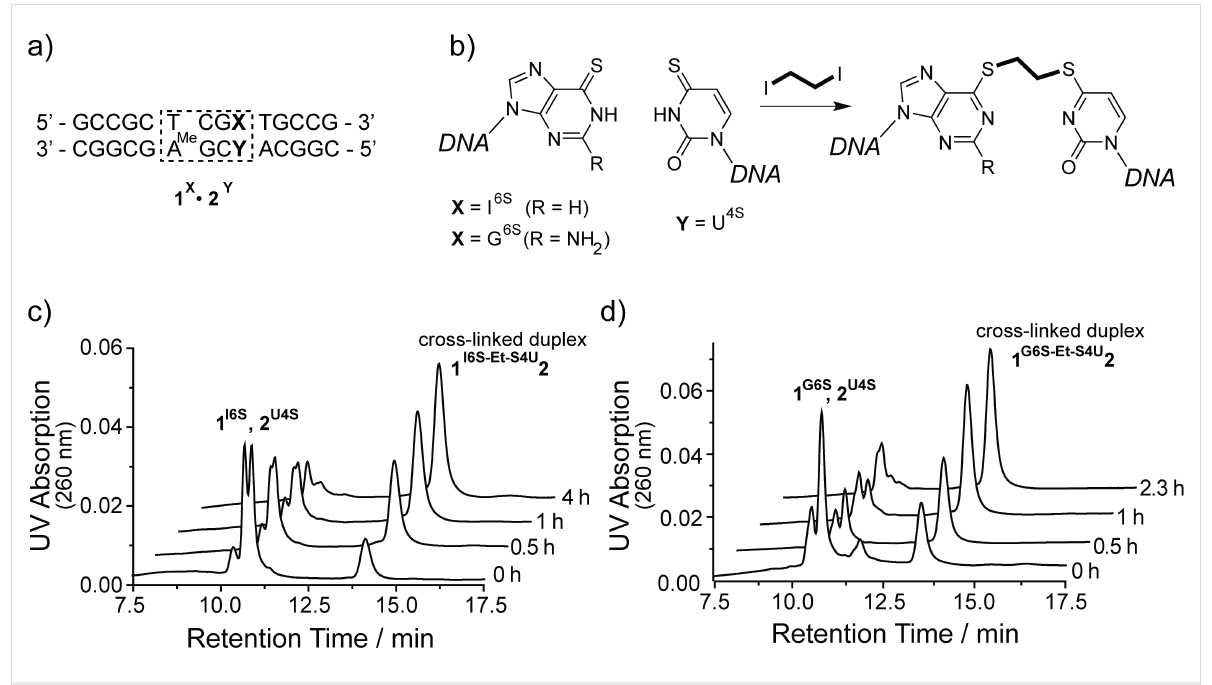
Figure 1: Covalent cross-linking of a I 6S /U 4S or G 6S /U 4S base pair within duplex ODN 1 ∙ 2 (a) by bis-alkylation with 1,2-diiodoethane at pH 9.0 (b). The time course for the reaction of duplexes 1 I6S ∙ 2 U4S (c) and 1 G6S ∙ 2 U4S (d) is monitored by denaturing anion exchange HPLC. The non-cross-linked parent duplexes dissociate and elute as their respective single strands, while the covalently linked duplexes elute significantly